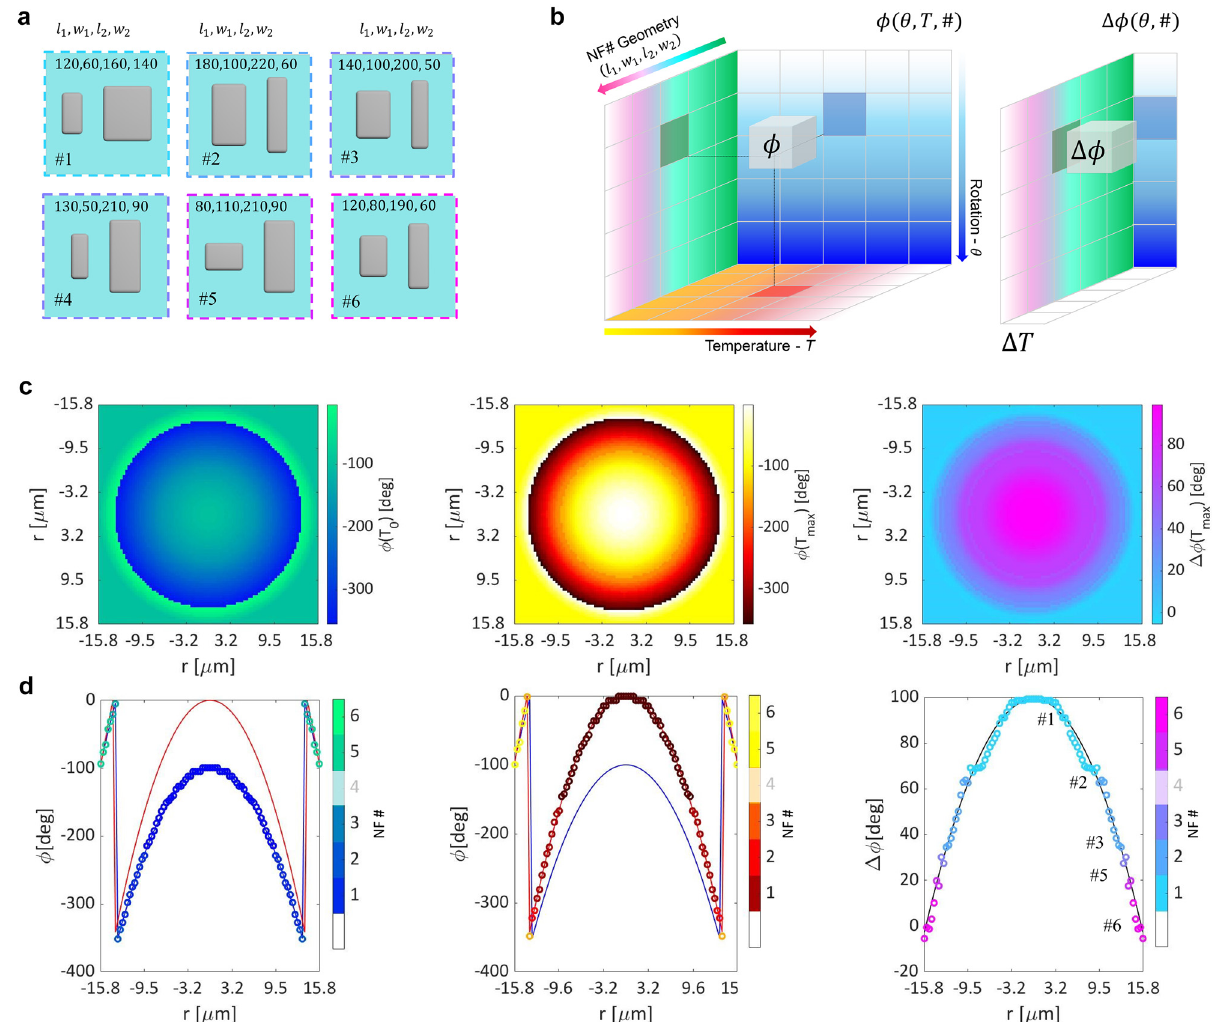
Figure 2: Study of the thermo-optic response of nanofins with different geometrical parameters and relative rotation. , w , w (a) Schematic illustration of a unit nanofin NF # structure and its geometrical parameters; ( l , l ), g , h , p and 𝜃 are the width and the 1 1 2 2 length of the nanopillar 1 and 2, the gap between the two nano-pillars, the height of the nano-pillars corresponding to the initial c-Si film thickness, the nano-fin lattice period and the angle of rotation of the nanofin structure respectively. gap = 0.060 μ m, h = 0.300 μ m, p = 0.350 μ m. (b) 𝜙 ( 𝜃, T , # ) and Δ 𝜙 ( 𝜃, # ) are a 3D and 2D matrices representing the phase parameter space used for the wavefront design. (c) Left and center 2D metalens phase profile at 20 ◦ C and 260 ◦ C respectively. (c) Right metalens phase shift between 260 ◦ and 20 ◦ C. (d) Left and center 1D projection of the 2D plots (c) left and center respectively. Circle markers represent the actual ML phase value at a specific radial position overlapped to the theoretical phase values displayed with a continuous line (blue and red color indicates 20 ◦ C and 260 ◦ C respectively. (d) Right 1D projection of the 2D plots in (c) right. Circle markers represent the actual ML phase shift value at a specific radial position overlapped to the theoretical phase shift values displayed with a continuous black line. Different gradual colors in plot (c) and (d) represent different nanofin (#1–6). Notice that the nanofin #4 has not been selected by the algorithm for the ML design. All the phase = 20 ◦ C. All the nanofin structures have been studied with COMSOL shift profiles are computed with respect to the initial temperature T 0 numeric simulations to retrieve their phase and transmission efficiency at different temperatures and rotation angles 𝜃